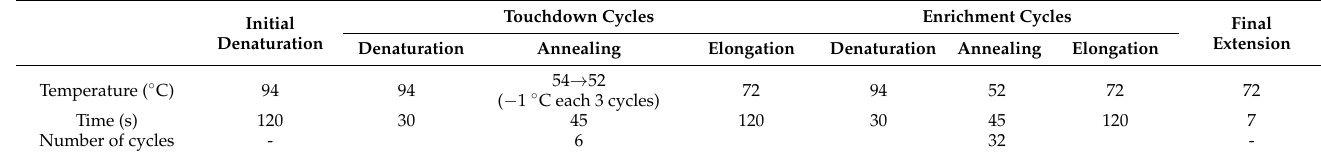
Table 2. Thermocycling program used for ISSR